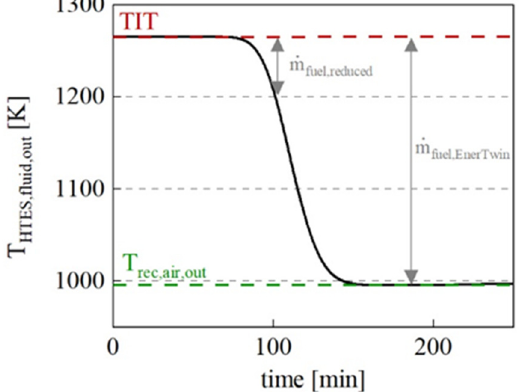
Figure 2. Exemplary HTES outlet temperature profile as a function of time within the temperature boundaries of the EnerTwin